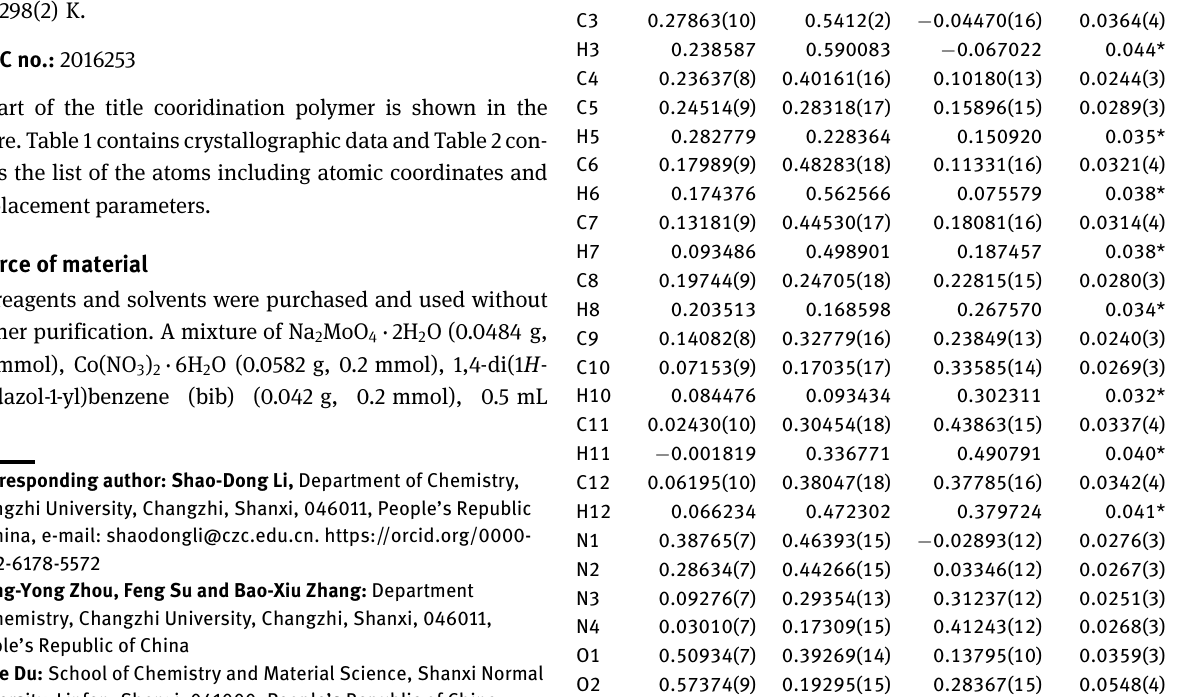
tains the list of the atoms including atomic coordinates and displacement parameters.